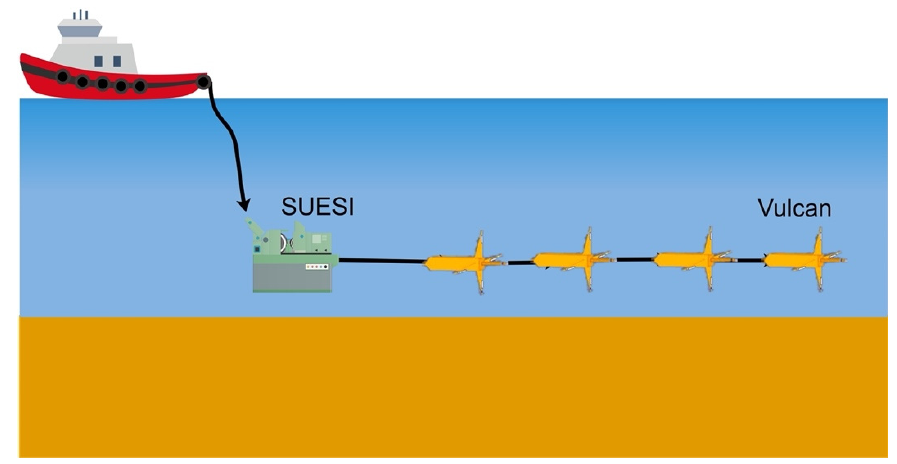
Figure 6. The SUESI with Vulcan configuration (adapted from [26] ).